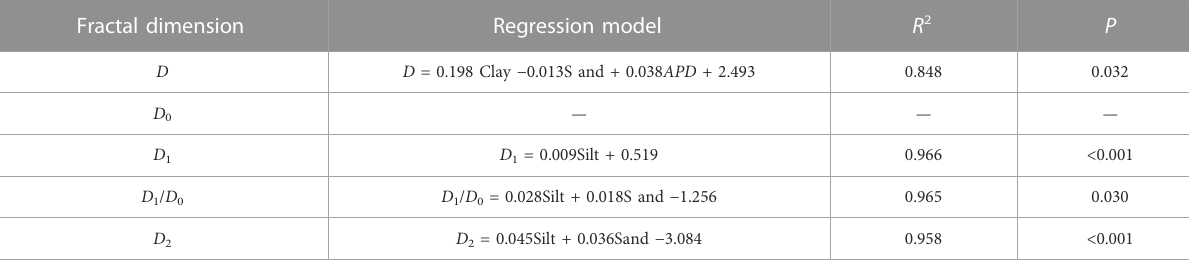
TABLE 3 Stepwise regression models of soil fractal dimensions, PSD, and pore parameters. Fractal dimension Regression